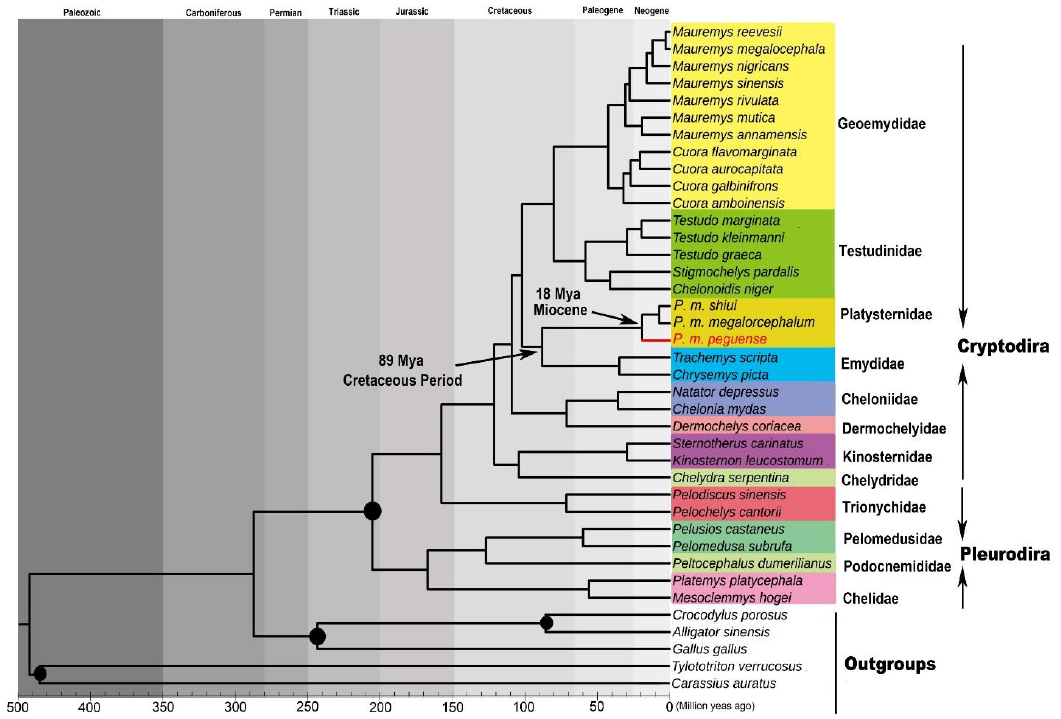
Figure 6. Time tree of Platysternon and turtles based on the concatenated nucleotide sequences of 13 PCGs using BEAST analysis. Four nodes were used for fossil-calibrated time points (solid black circles). Species specific taxonomic ranks were incorporated with specific clades.